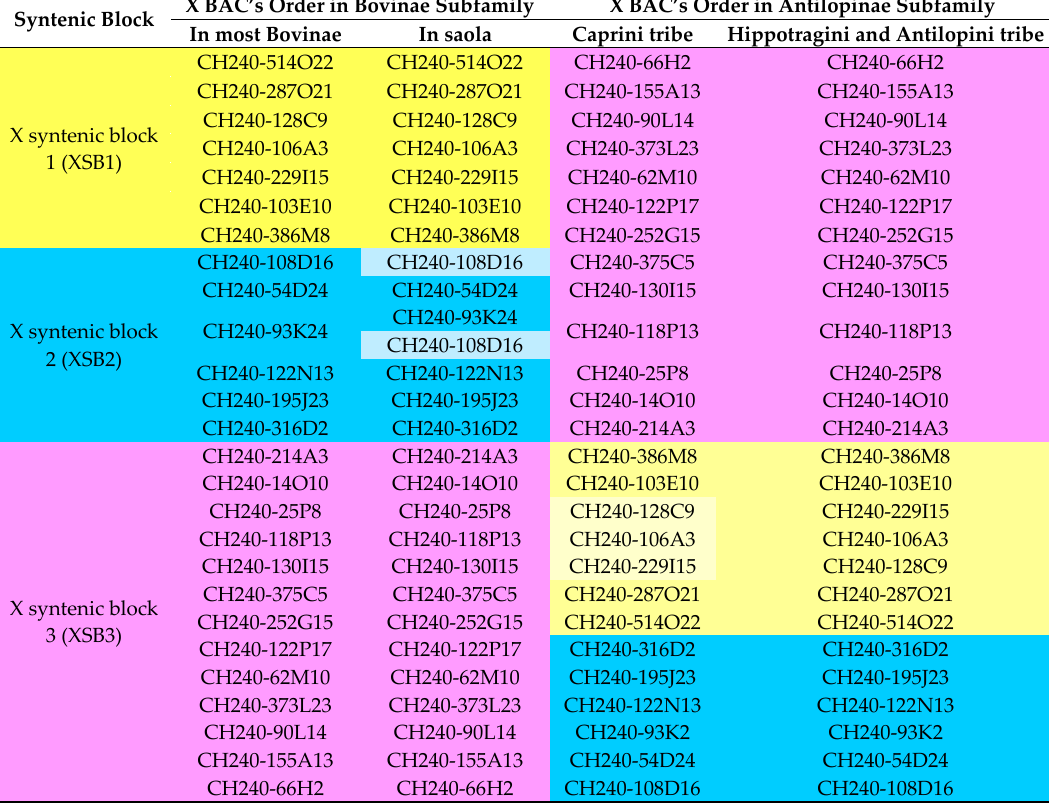
Figure 3. The duplication of the X chromosome segment in Pseudoryx nghetinhensis (PNG) shown by dual color FISH of cattle BAC-clones (pink and green) from CHORI-240 library. Three FISH experiments illustrate the revealed order of BACs on the X chromosome: 386M8, 108D16, 54D24, 93K24, 108D16. White arrows indicate the duplicated region corresponding to 108D16: 1, 2 –54D24 and 93K24 are between duplicated regions, 3 –386M8 is outside of duplicated region. Table 3. The order of 26 CHORI-240 BACs on Bovidae X chromosomes. The color of the cells corresponds to a given conserved syntenic segment. To display the complete scheme of evolution in Bovidae, the X chromosome maps published previously are also presented [15]. The region duplicated in saola and inverted in Caprini is labeled with a lighter colour.